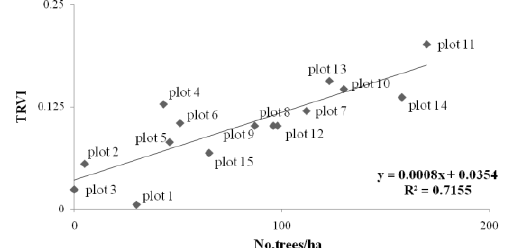
Figure 7. The relationship between pistachio tree density and TRVI vegetation